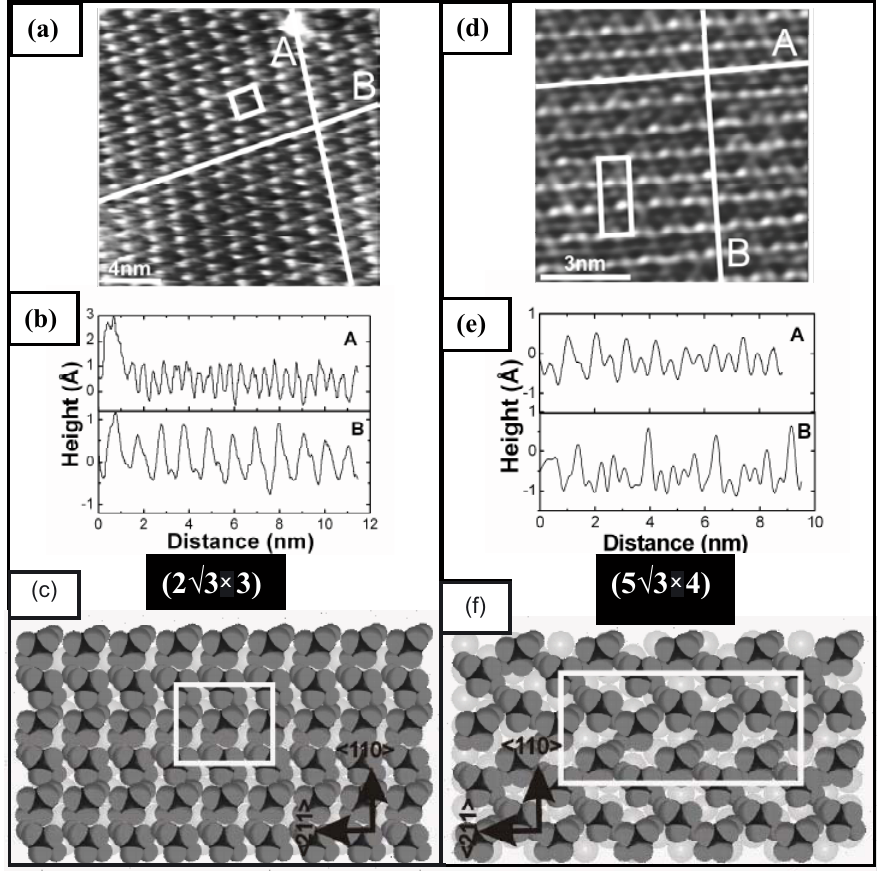
Figure 4. (a) and (d) Constant-current STM images showing the gold surface after immersing into 100 μM ethanolic solution of BP2 at 343 K for 2 h. The rectangular unit cells of the (2 √ 3×3) and (5 √ 3×4) structures are marked in (a) and (d), respectively; (b) and (e) cross-sectional height profiles along the lines A and B labeled in (a) and (d), respectively; (c) and (f) top views of (2 √ 3×3) and (5 √ 3×4) models, respectively. Tunneling parameters: (a) U= 530 mV; 148 pA and (d) U= 530 mV; 148